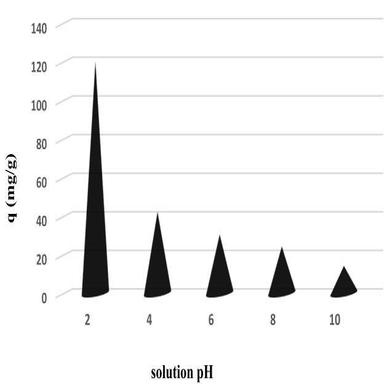
pH influence on the 2,4-D adsorption by FLPWAC composite.